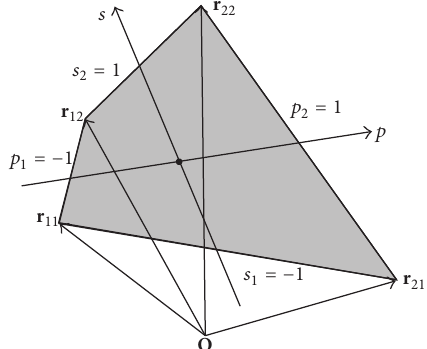
Figure 2: Bilinear quadrilateral patch with its local coordinates 𝑝 and 𝑠